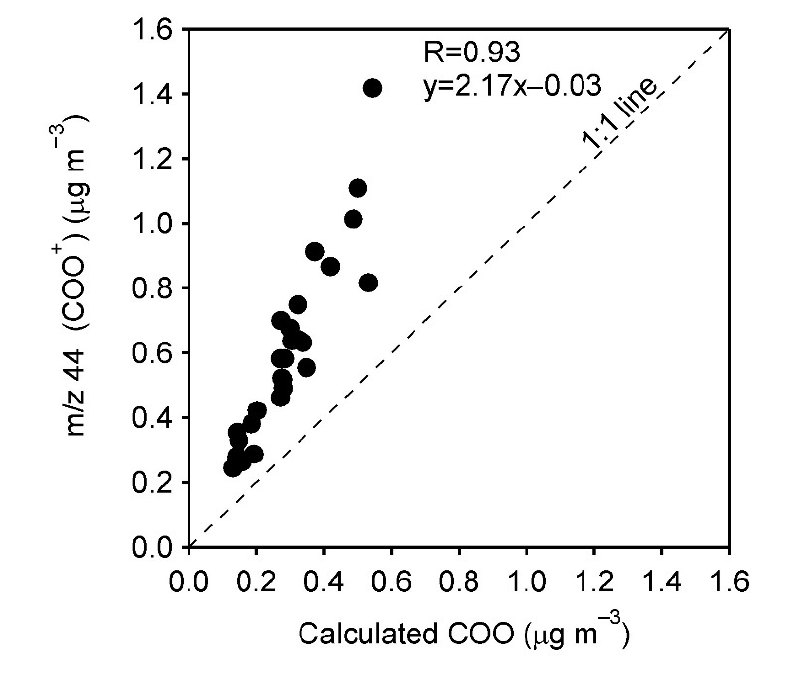
Figure 6. Correlation plot for the m/z 44 (COO + ) signal measured by AMS and COO calculated for all carboxylic acids (diacids, oxoacids, benzoic acid, and fatty acids) measured by GC.